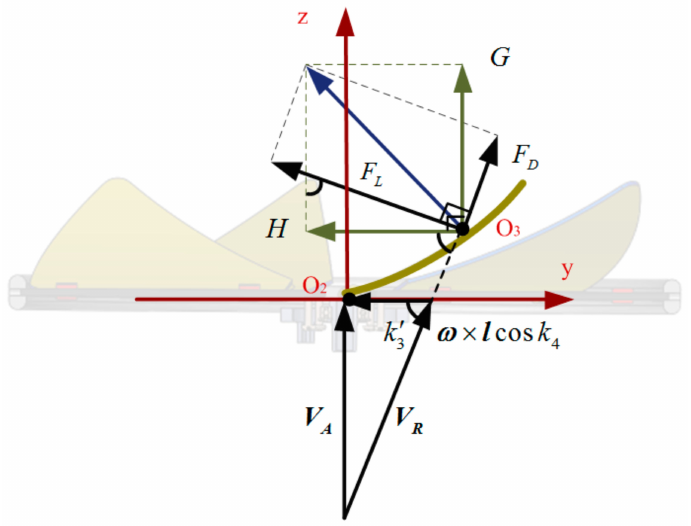
Figure 15. Decomposition of blade